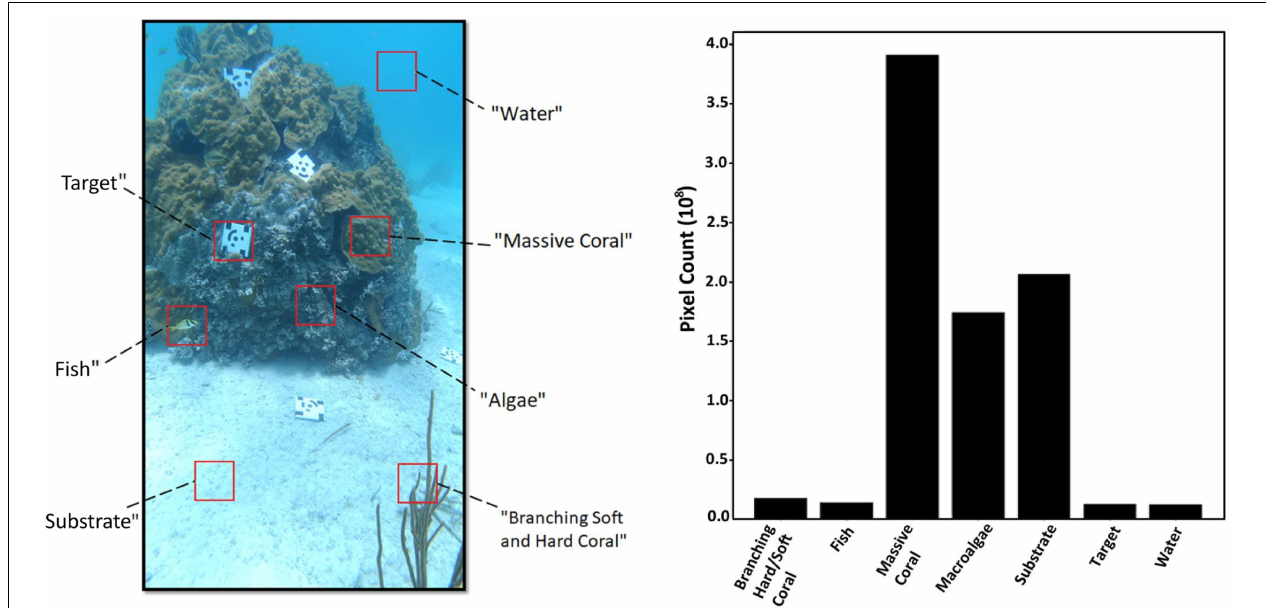
FIGURE 4 | A still image (2160 pixels × 3840 pixels) extracted from the video footage showcasing the class categories used in this study (left), and the distribution of each class category based on their pixel count calculated from the 50 ground-truth dense labels within the testing set (right).